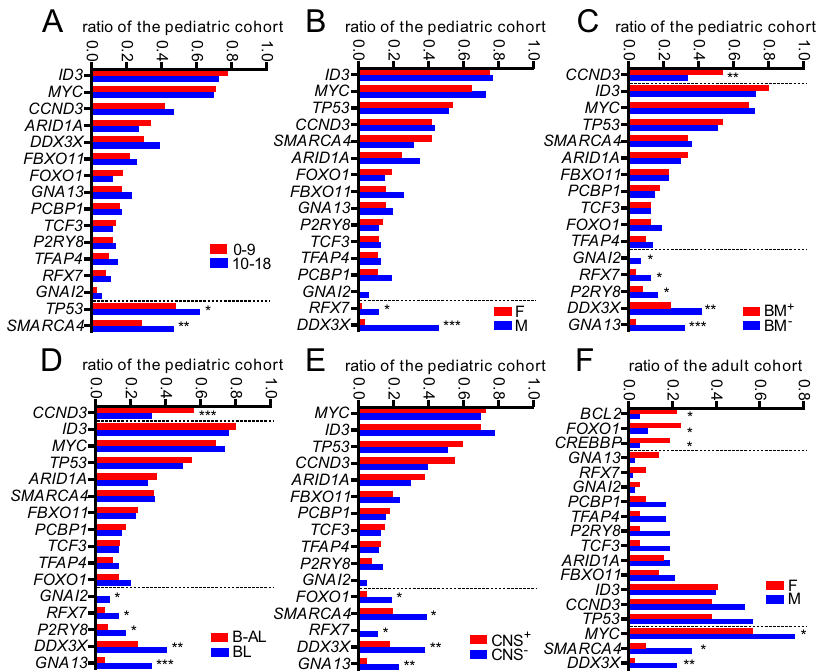
Fig. 4 Mutational frequencies associated with clinical characteristics. For the pediatric cohort, gene mutation rates were associated with the following clinical characteristics: age dependency ( A ); sex ( B ); BM (bone marrow, C ); B-AL vs. BL ( D ); and, central nervous system (CNS, E ). F shows the sex- speci fi c differences in the adult cohort. FOXO1 , BCL2 , and CREBBP are predominantly found in the female cohort, while MYC , SMARCA4, and DDX3X are overrepresented in the male cohort ( P values by one-sided exact Fisher tests, see Supplementary Data 8 for all P values and FDRs, * P ≤ 0.05, ** P ≤ 0.01, *** P ≤ 0.001.